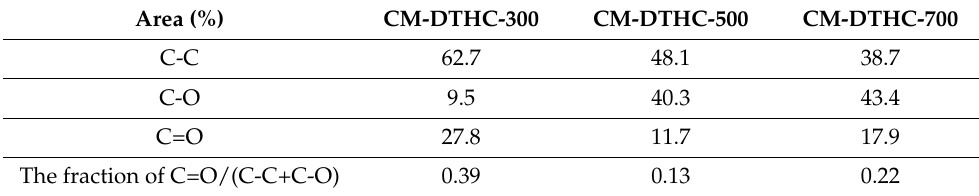
Table 8. The result of C1s XPS spectra of CM-DTHCs.